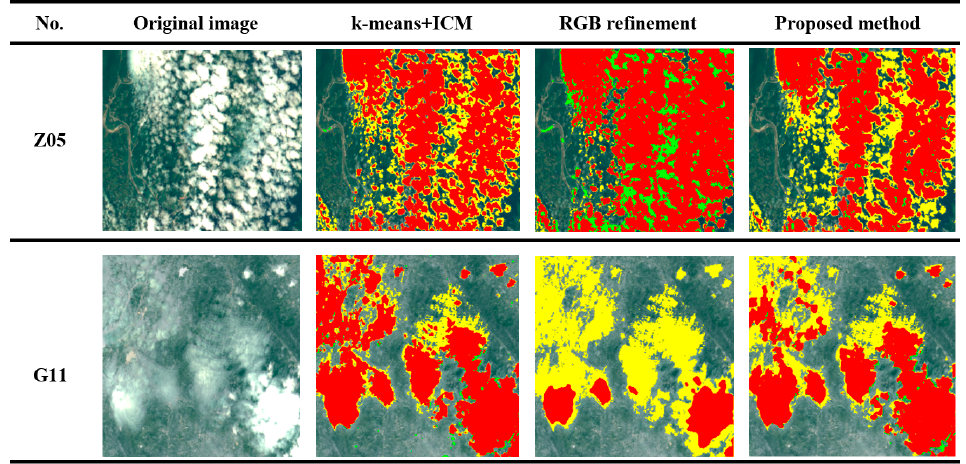
Figure 19. Results of comparison with other algorithms in the failed cases (Red denotes the extracted true cloud regions, yellow denotes the missed true cloud regions, green denotes the non-cloud regions misjudged as cloud regions)